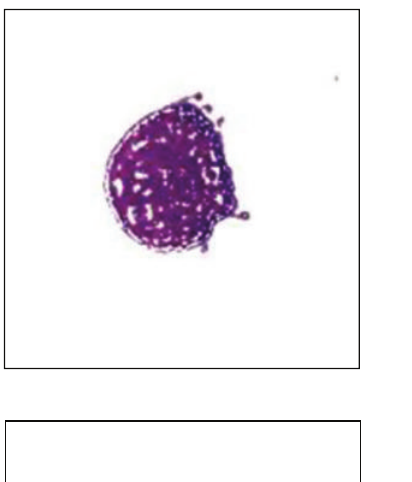
The color features, Hue var , Saturation var , and Intensity var , are the three variances of the hue, saturation, and intensity components of the pixels belonging to the white